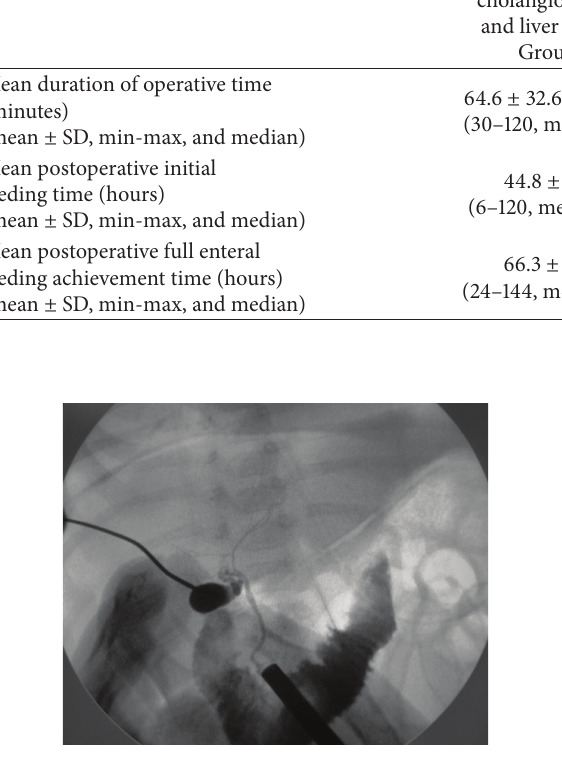
Figure 3: Cholangiography: passage of the contrast agent into the intrahepatic ducts and into the intestinal system excludes biliary atresia.